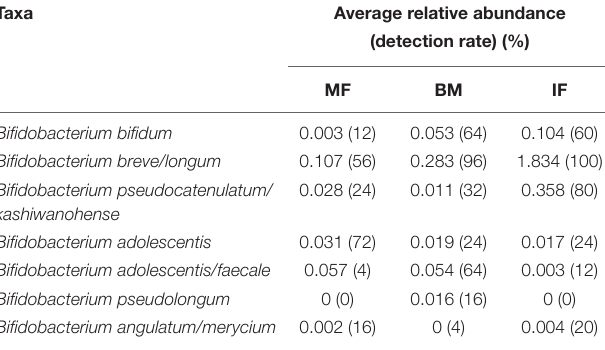
TABLE 2 | The relative abundance and detection rate of bifidobacteria group obtained by the National Center for Biotechnology Information (NCBI) comparison in the three